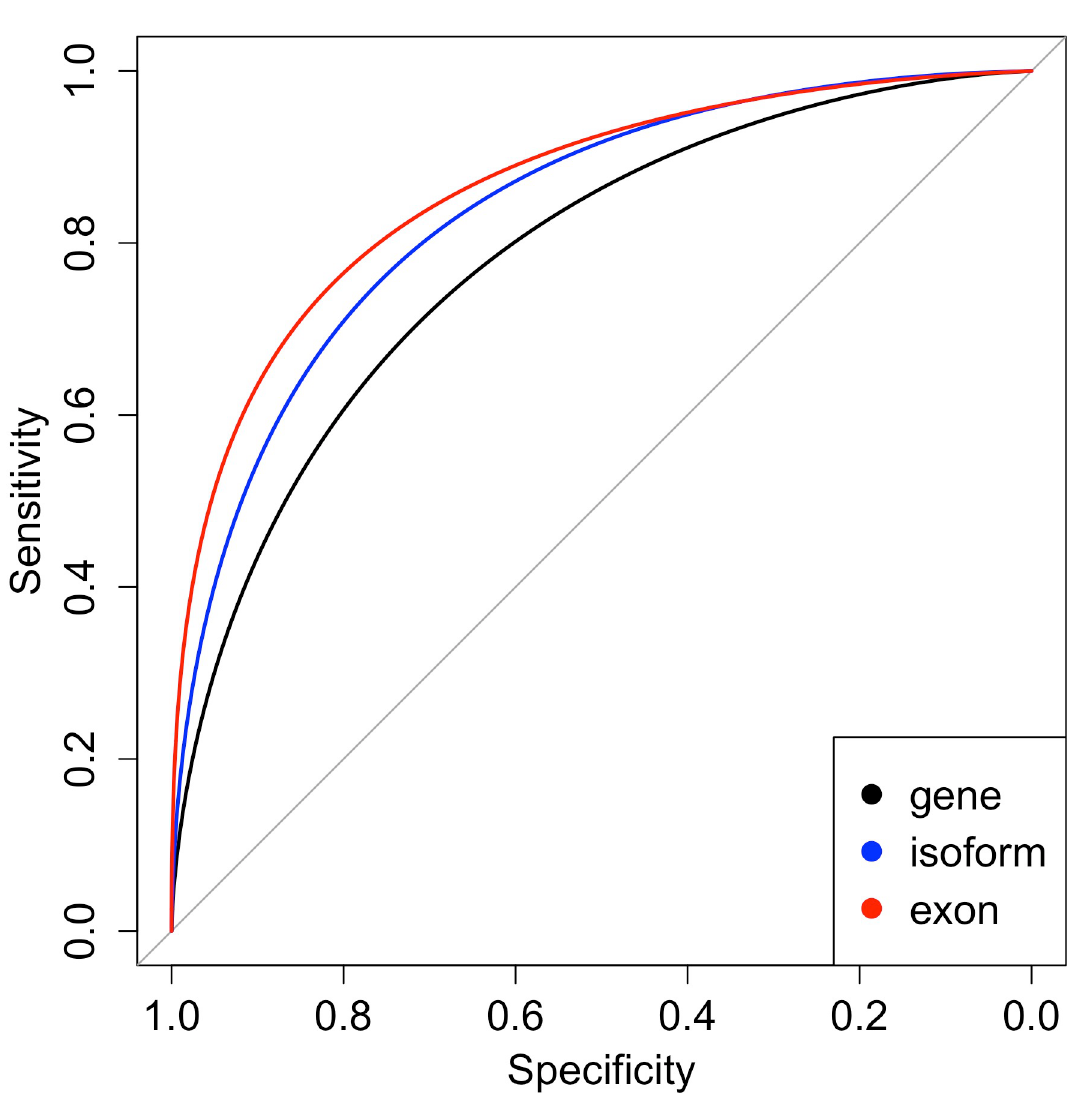
Fig 2. ROC curves in test data for the 4-gene modified Beineke model using gene (black), isoform (blue), and exon-level (red) quantifications. Isoform and exon-level data outperform gene-level data (Delong p = 0.002 and < 0.001, respectively).